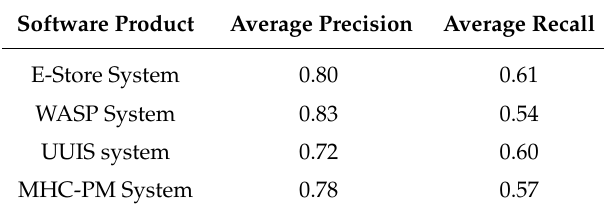
Table 2. Average Precision and Recall of the identified clusters for each software product.